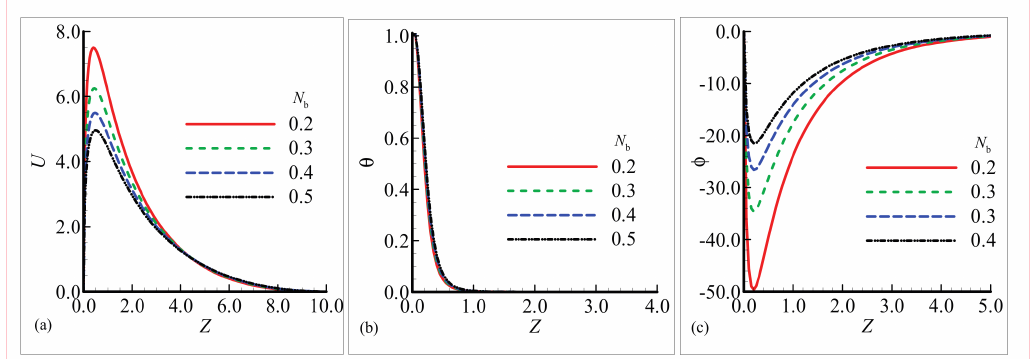
Figure 12. Physical e ff ects on quantities ( a ) u , ( b ) θ , and ( c ) ϕ versus Nb, when Nt = 0.5, Sc = 0.3, Pr = 0.71, M = 0.4, Q = 0.4.